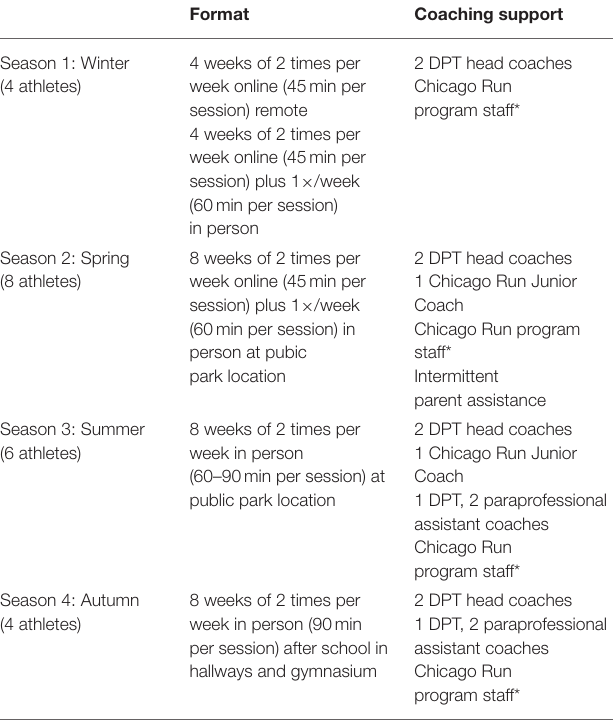
TABLE 2 | Season formats.